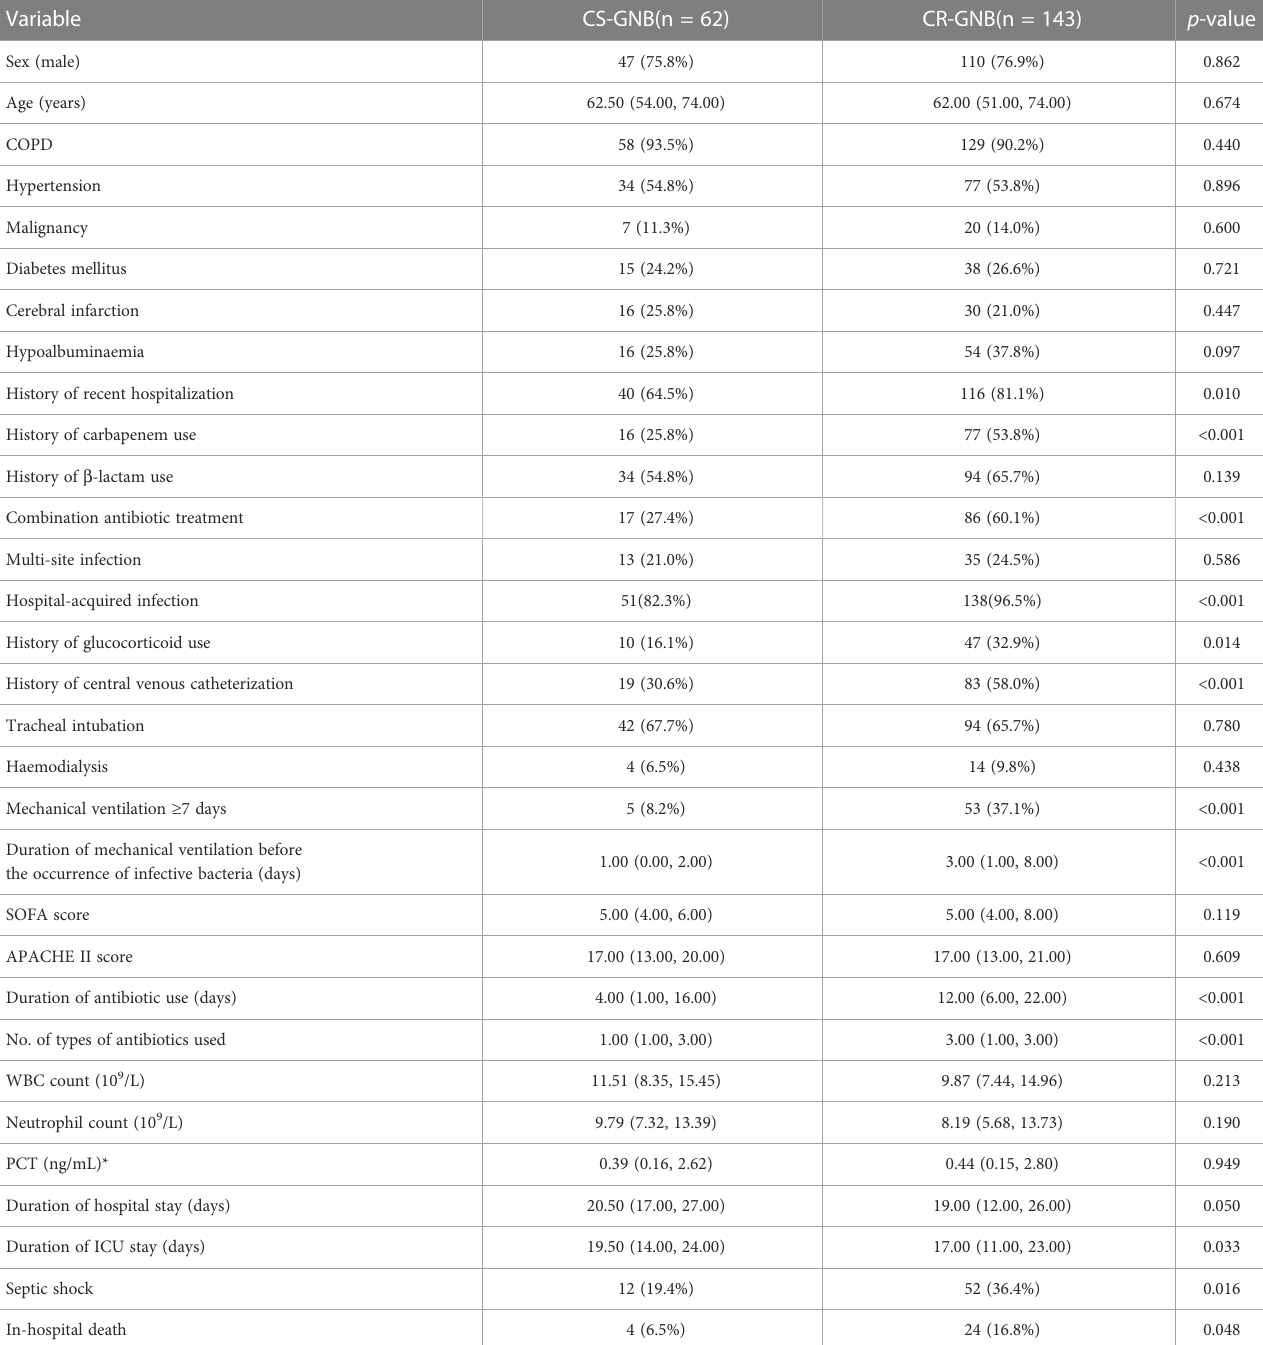
TABLE 4 Comparison of baseline characteristics between the CS-GNB and CR-GNB groups of the experimental cohort.